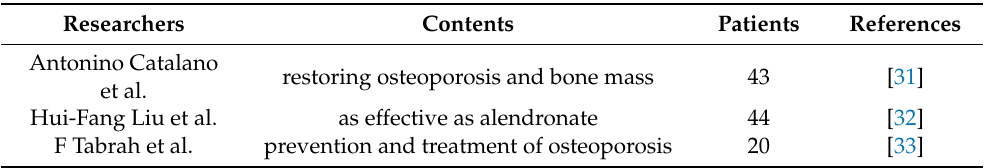
Table 1. The clinical research of PEMFs in